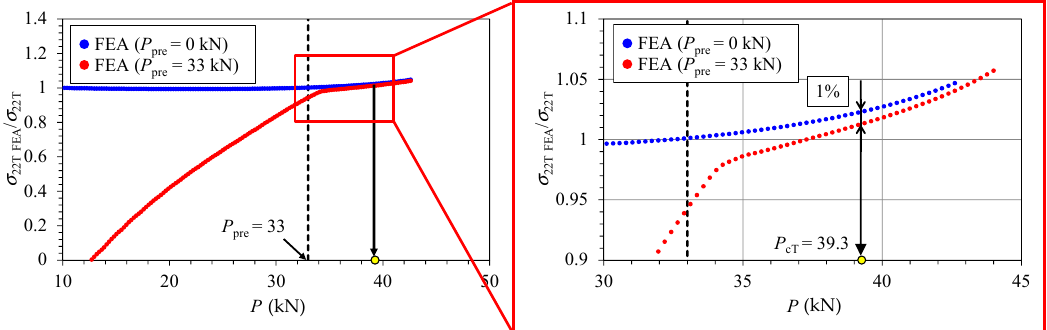
Figure 12. Comparison of relationship between normalized midplane crack-opening stress on x 1 -axis σ 22T FEA / σ 22T and load P without and with CRS for S45C. The difference in σ 22T FEA / σ 22T between the two cases became smaller than 1% when the load reached P cT = 39.3 kN for the case with CRS, and this load was used as the predicted fracture load.